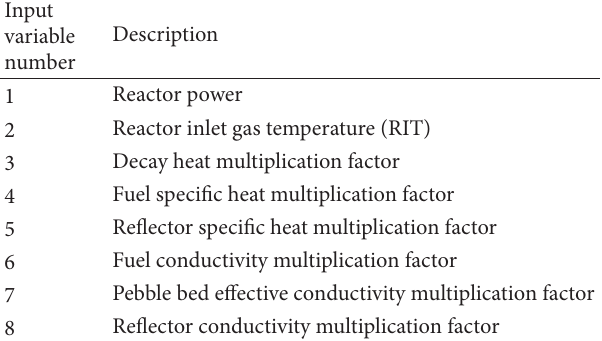
T 5: Indices for data in Figure